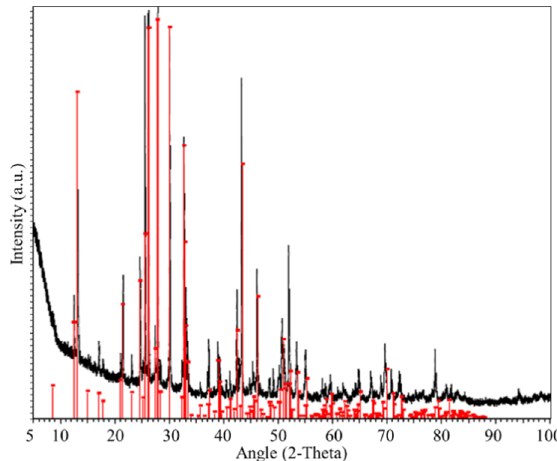
Figure 2. XRD pattern of Cs 3 Bi 2 I 9 perovskite powder.